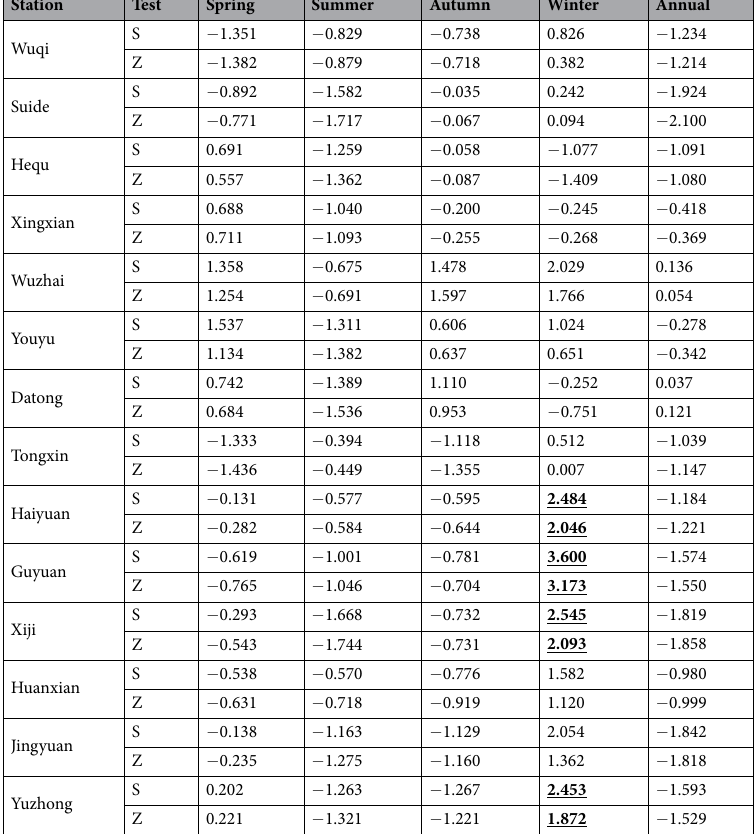
Table 5. Results of the statistical tests of seasonal and annual SPI in the study period. Z: M-K trend test; S: Spearman’s rho test; and b (mm/a): slope of linear regression. Bold type represents trends identified by 2 statistical methods and trends that are statistically significant at the 5%